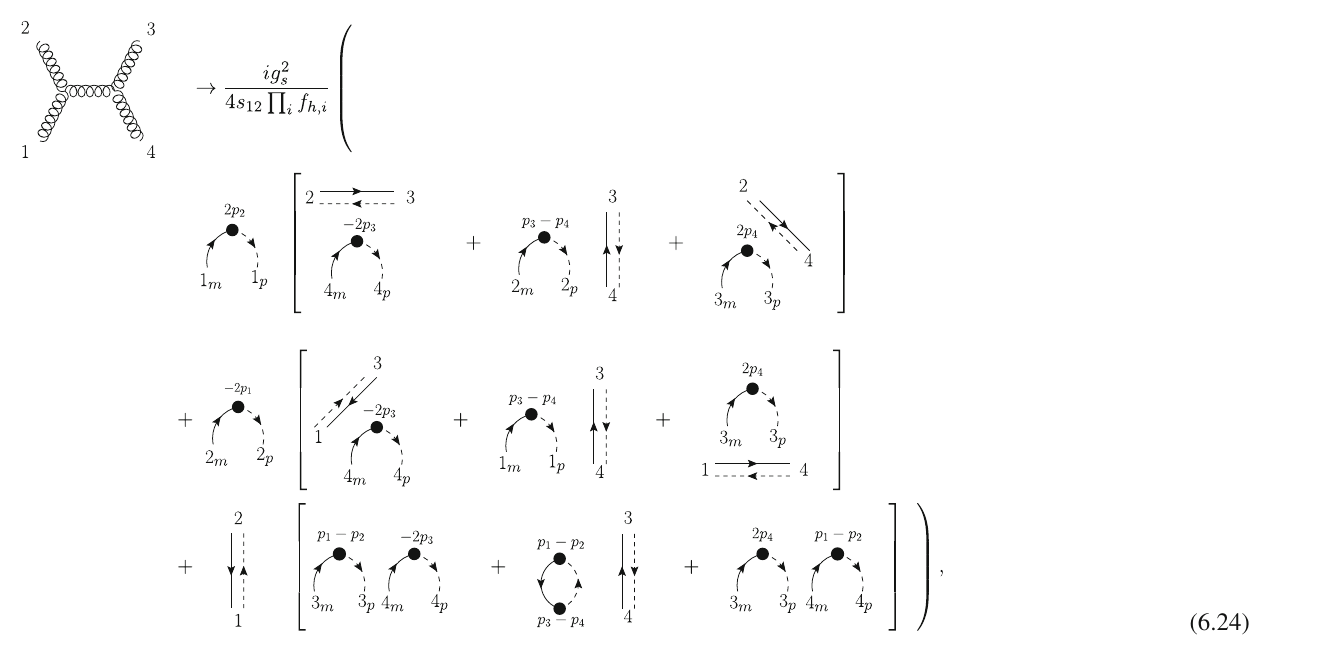
ing together the two factorized terms and assigning arrows results